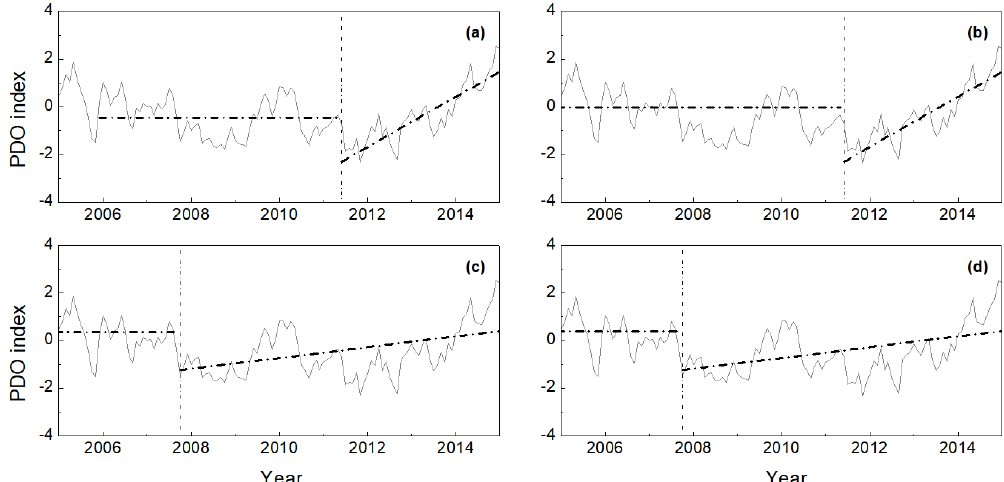
Figure 8. The PDO time sequences and the detection of parameters v and h when the subsequence was set as (a) 10 years, (b) 20 years, (c) 30 years and (d) 40 years. The gray lines represent the PDO time sequence. The horizontal dashed lines represent initial states, the sloped dashed lines represent the linear trend lines of the transition process and the vertical dotted lines represent the start moment.